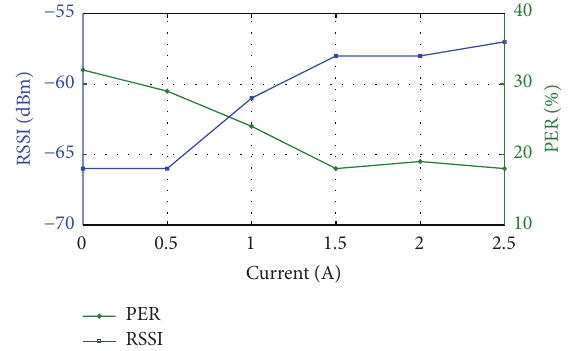
Figure 9: Measurements of RSSI and PER parameters as a function of the laser current.